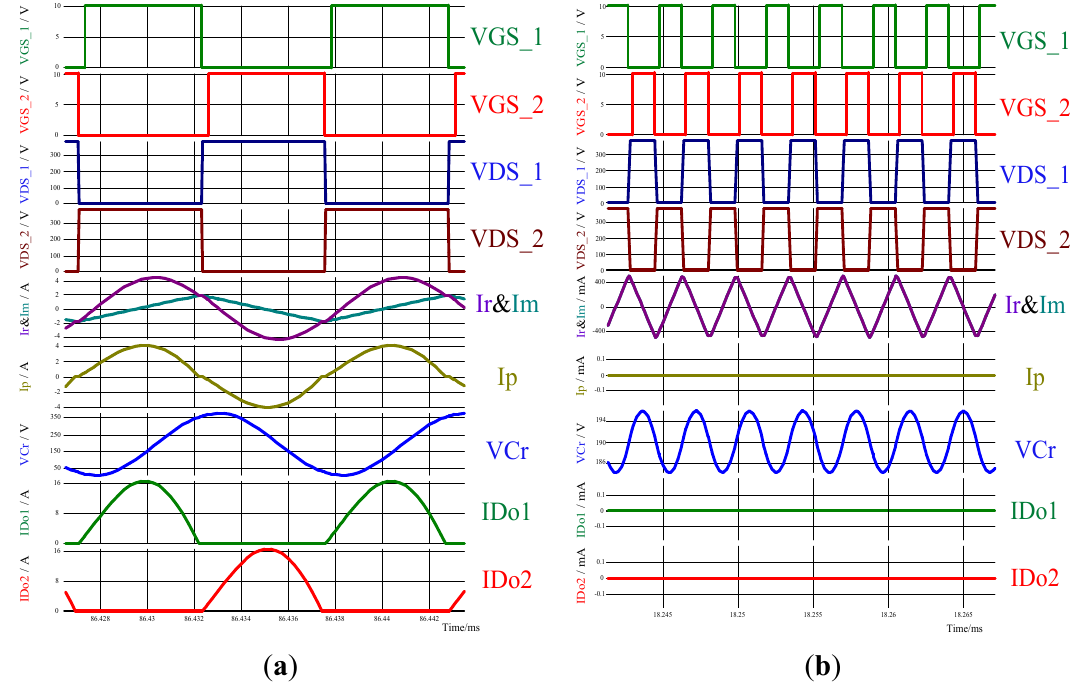
Figure 10. Simulation waveforms for typical LLC circuit at 480 W/48 V: ( a ) 100% load; and ( b ) 0%